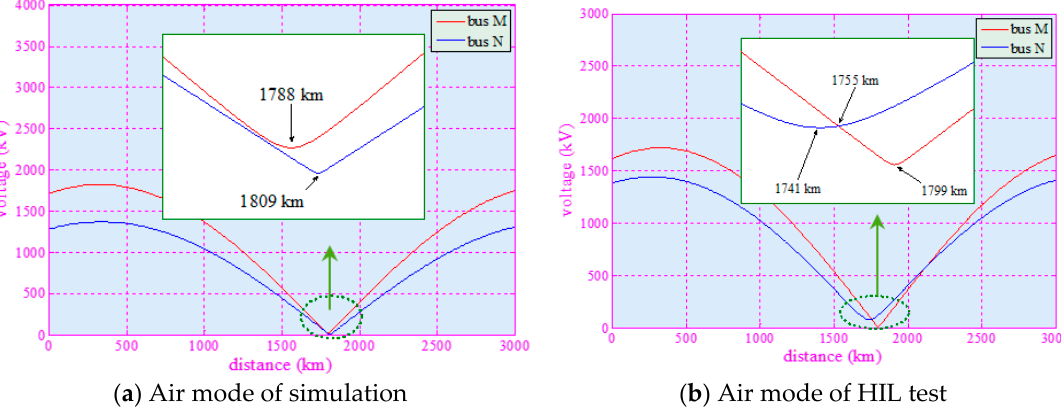
Figure 13. A three-phase (ABC) fault with 10 Ω fault resistance, 1800 km away from bus M, with 550 MW wind power.